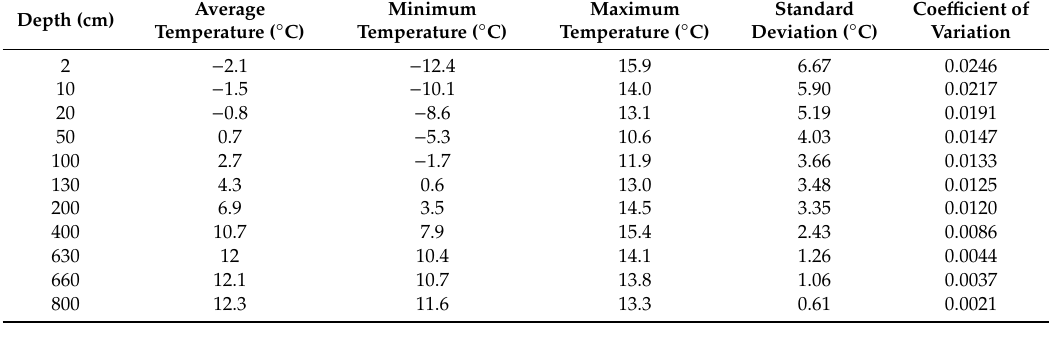
Table 3. Daily temperature characteristics calculated for di ff erent depths. The coe ffi cient of variation is calculated based on the Kelvin temperature scale.